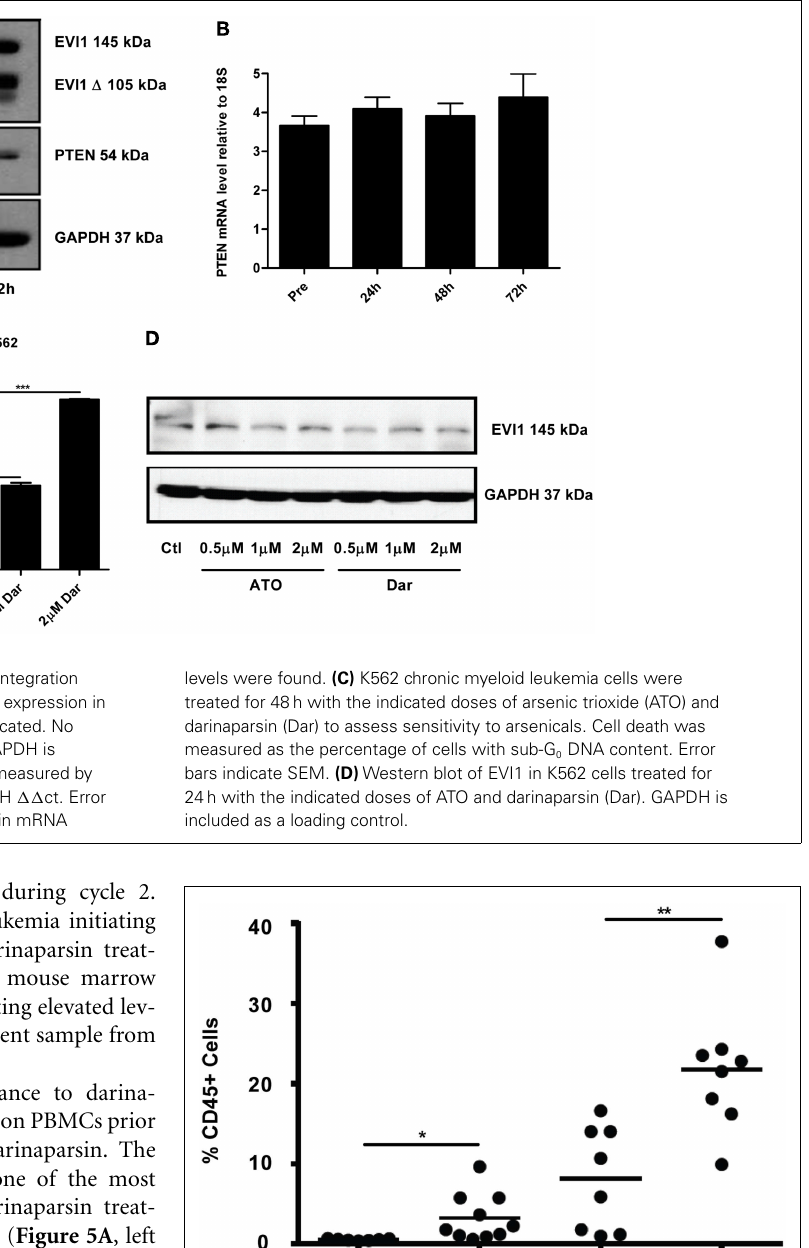
FIGURE 4 | Percentage of engraftment in NOD/SCID/IL2R γ c mice for the indicated cells. Each symbol represents a single animal analyzed 12weeks after transplantation, mean engraftment is indicated by horizontal bars.The percentage of human CD45 in the BM was determined via flow cytometry. pathway to darinaparsin treatment coincides with emergence of resistance, thereby strengthening the hypothesis that this pathway plays a role in the sensitivity/resistance of inv(3) AML cells to